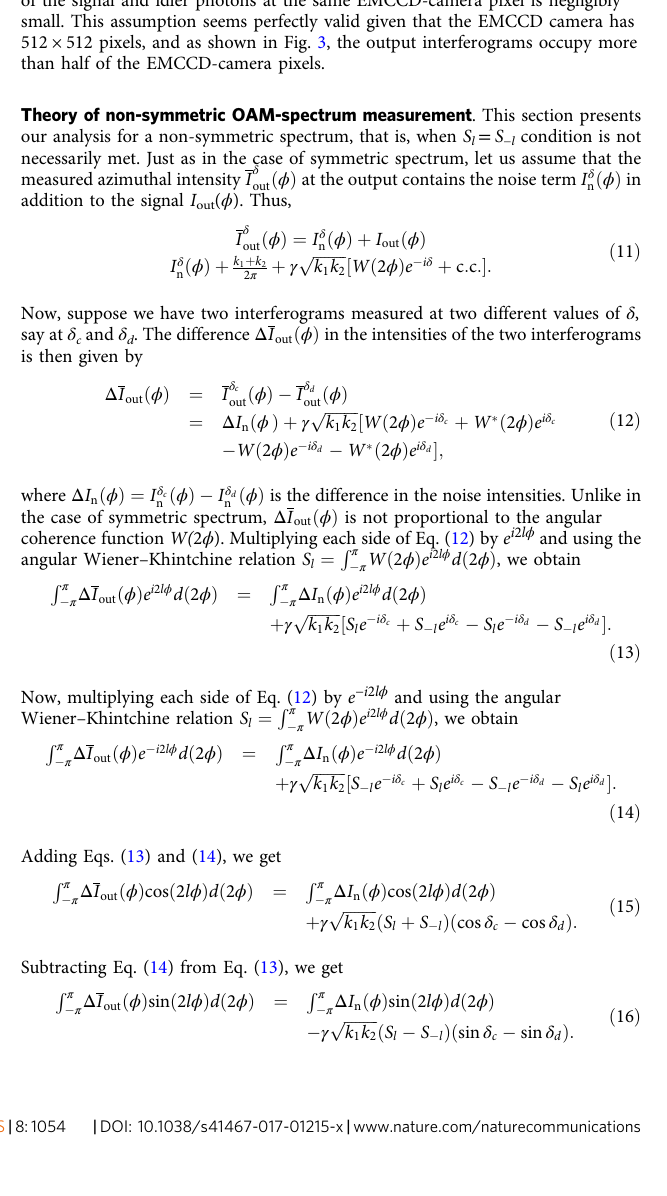
interferometer was covered after the required alignment with a box and the measurements were performed only after it had stabilized in terms of ambient fl uctuations. Details of the experiment measuring angular Schmidt spectrum . As depicted in Fig. 1b, a 405 nm ultraviolet pump laser with a beam radius 0.85mm and having a Gaussian transverse mode pro fi le was made incident onto a 2-mm thick BBO crystal. The crystal was phase-matched for collinear type-I PDC. The pump power of 100mW ensured that we were working within the weak down-conversion limit, in which the probability of producing a four-photon state is negligibly small compared to that of producing a two-photon state. The residual pump photons after the crystal were discarded by means of a dichroic mirror. The down-converted photons were passed through an interference fi lter of spectral width 10nm cen- tered at 810 nm and then made incident into the Mach – Zehnder interferometer of Fig. 1b. The output of the interferometer was recorded using an Andor iXon Ultra EMCCD camera having 512 ×512 pixels with the acquisition time of 13s. The azimuthal intensity I δ out ð ϕ Þ plots were obtained by fi rst precisely positioning a very narrow angular ROI at angle ϕ in the interferogram image and then integrating the intensity within the ROI up to a radius that is suf fi ciently large. To reduce pixelation-related noise, the interferograms are scaled up in size by a factor of eight using a bicubic interpolation method. We note that since we are using collinear down-conversion, the individual signal and idler photons have equal probability of arriving at a given output port of the interferometer. As a result, what is recorded by the camera at a given output port is the sum of the interferograms produced by the signal and idler fi elds at that output port. However, since the individual signal and idler fi elds have the same OAM spectrum, the azimuthal pro fi le of the sum interferogram is same as that of the individual interferograms produced by either the signal or the idler fi eld. One assumption that we have made here is that the probability of simultaneous arrivals of the signal and idler photons at the same EMCCD-camera pixel is negligibly small. This assumption seems perfectly valid given that the EMCCD camera has 512 × 512 pixels, and as shown in Fig. 3, the output interferograms occupy more than half of the EMCCD-camera pixels. Theory of non-symmetric OAM-spectrum measurement . This section presents our analysis for a non-symmetric spectrum, that is, when S l = S − l condition is not necessarily met. Just as in the case of symmetric spectrum, let us assume that the measured azimuthal intensity I δ out ð ϕ Þ at the output contains the noise term I δ n ð ϕ Þ